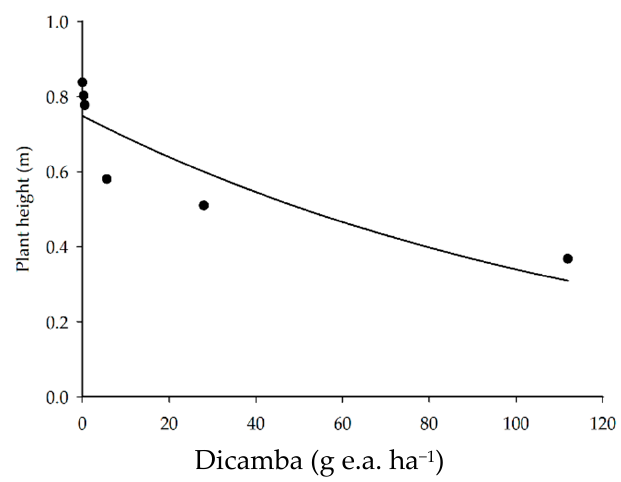
Figure 4. Soybean plant height as a function of the application of dicamba doses.